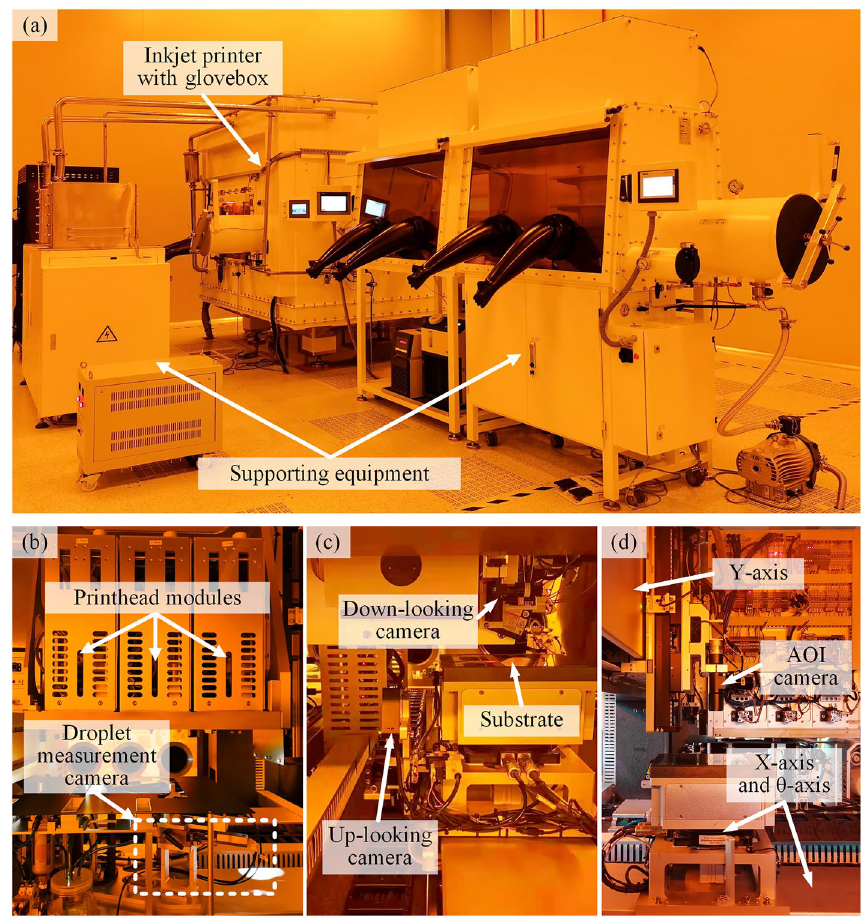
Figure 8. Inkjet printing system for printed display mass production. ( a ) The system with a glove box and supporting equipment. ( b ) Printhead module and droplet measurement camera. ( c ) Down-looking camera and up-looking camera. ( d ) AOI camera and motion